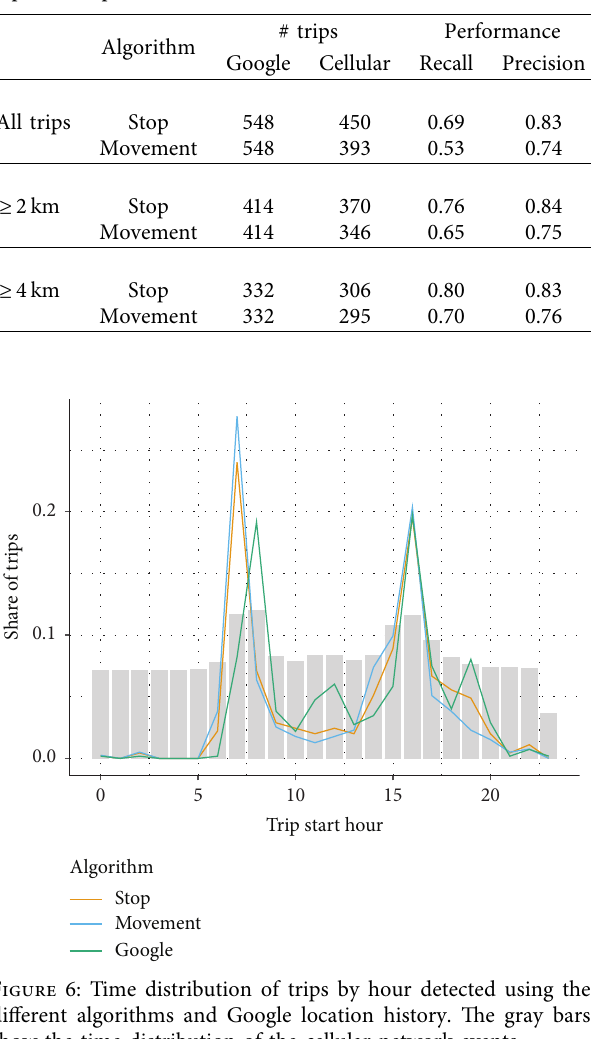
Table 4: Recall and precision achieved by the different trip ex- traction methods. The counts show the total number of Google trips and trips from cellular network data.